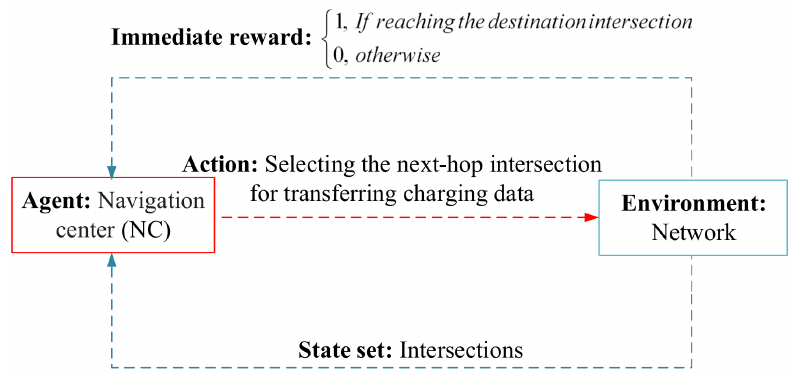
Figure 17. Learning structure in